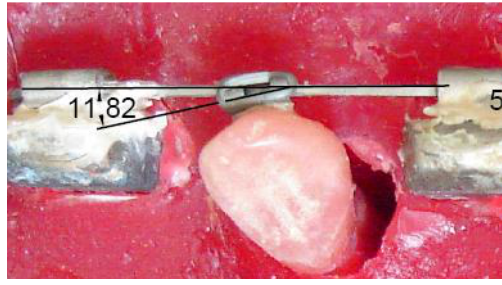
Figure 3: Measuring canine